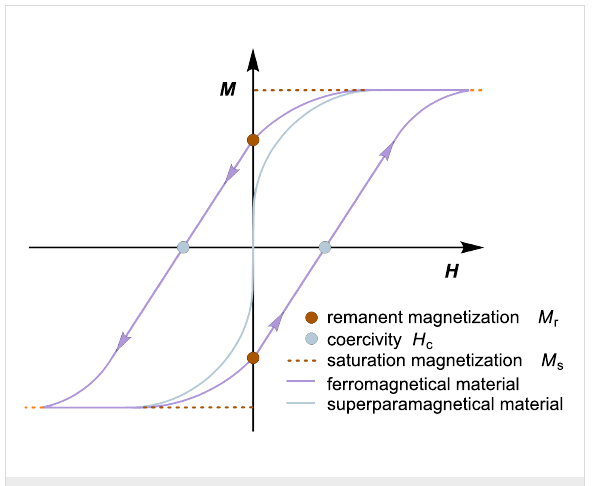
Figure 2: Electric displacement field of a ferromagnetic and superpara- magnetic